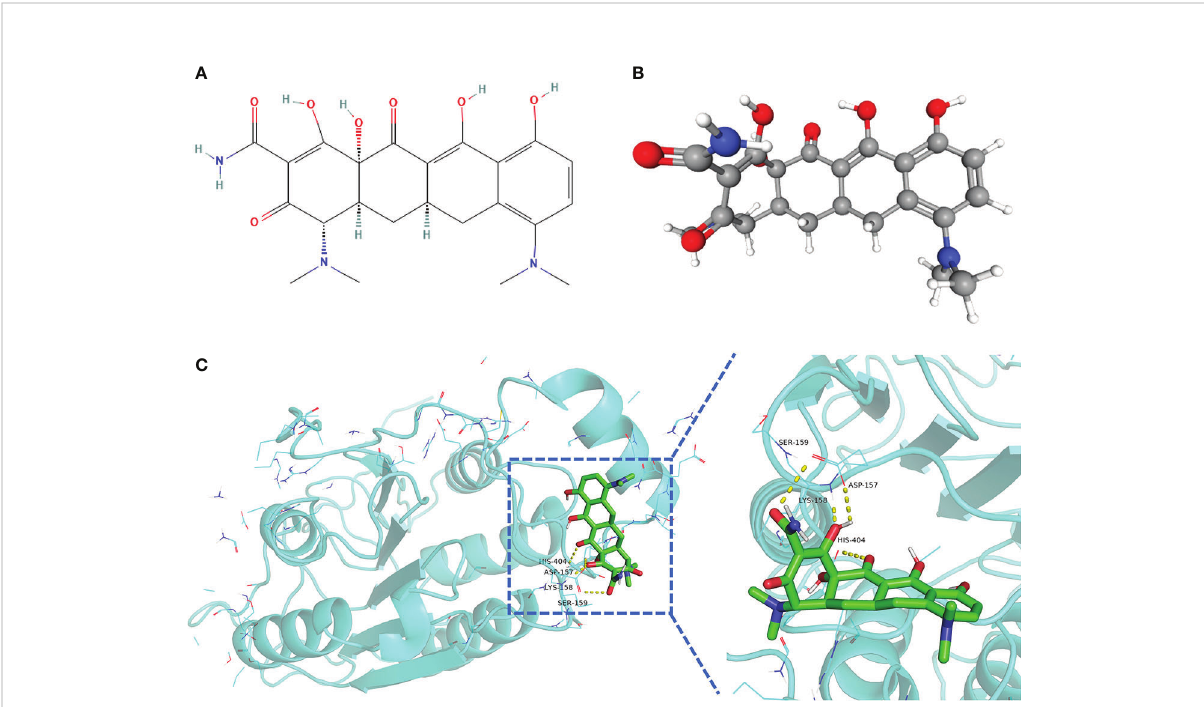
FIGURE 14 Structure of minocycline and molecular docking . (A, B) 2D and 3D structures of minocycline. (C) Results of molecular docking of minocycline with caspase-1